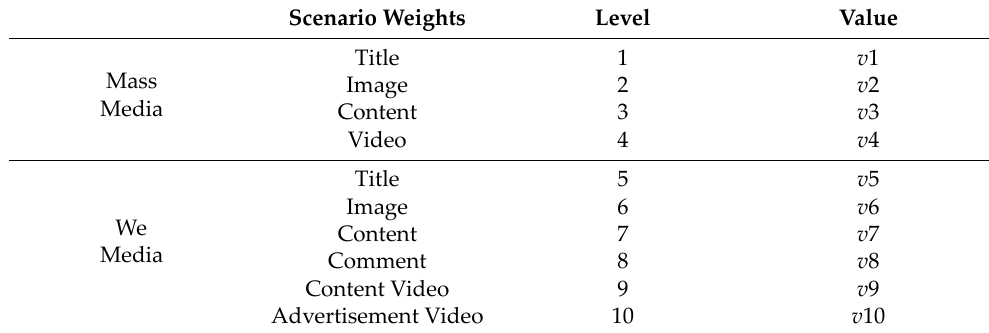
Figure 5. Two-dimensional Bag-of-words Model. Figure 5. Two‑dimensional Bag‑of‑words Model. Table 2. The Word Scene Coefficient